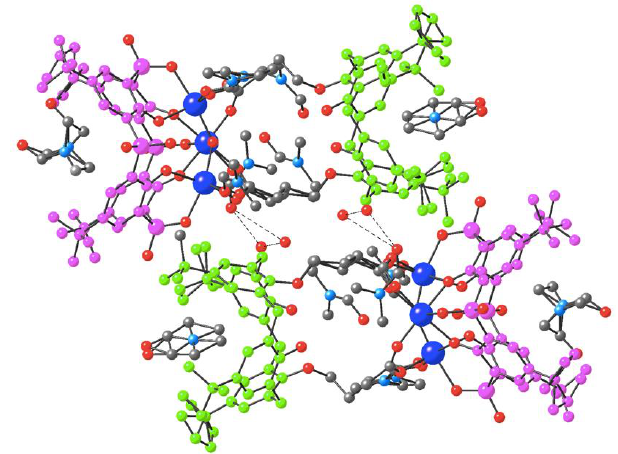
Figure 4. For Zn 3 (H 2 O)(DMF) 2 - (2 -2H )-3 (M = Co II , Ni II and Zn II ), view of the DMF crystal molecules encapsulated in the cones of ( 2- 2H) 2− (green) and 3 4− (pink) and the water molecules lying between the clusters. Table 2. The main distances for M 3 (H 2 O)(DMF) 2 -( 2 -2H)- 3 (M = Co II , Ni II and Zn II ) clusters.